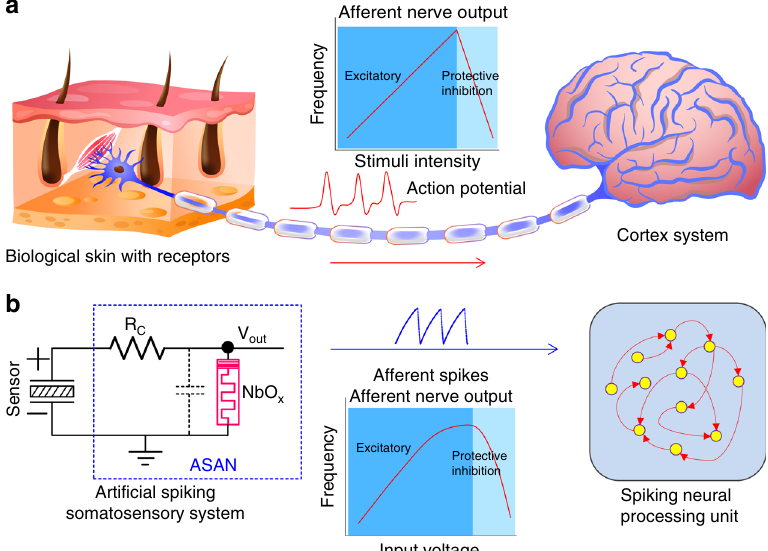
Fig. 1 Biological afferent nerve vs. arti fi cial afferent nerve. a Schematic of the afferent nerve of a biological somatosensory system. Action potentials are generated in the skin and transported to the brain for processing. Spiking frequency increases with increasing stimuli intensity and decreases under strong stimuli due to the protective inhibition. b The arti fi cial spiking somatosensory system, consisting of a mechanical sensor and an arti fi cial spiking afferent nerve (ASAN) made of a resistor and a NbO x memristor. The spiking frequency shows a similar trend to that seen in its biological counterpart, which is then transmitted to the spiking neural processing unit for further processing to complete a complex